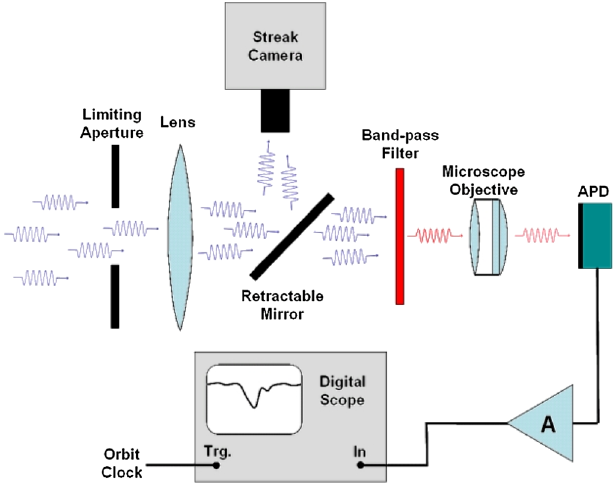
FIG. 1. (Color) Schematic diagram of the setup used for the experiment at the